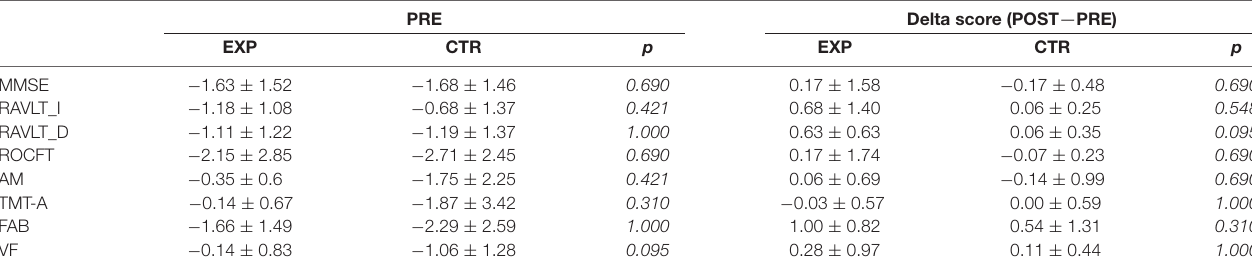
TABLE 2 | Pre-post assessment. PRE Delta score (POST — PRE)